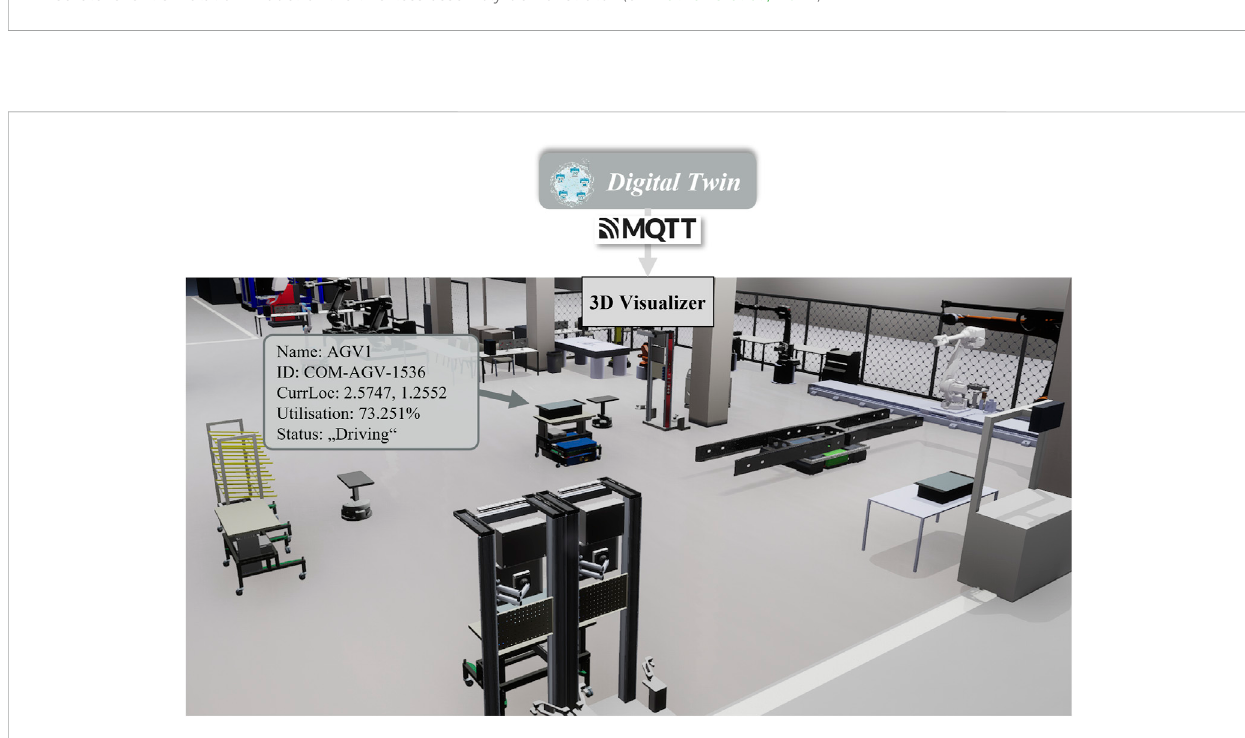
FIGURE 13 3D visualization based on the digital twin using MQTT-parsed